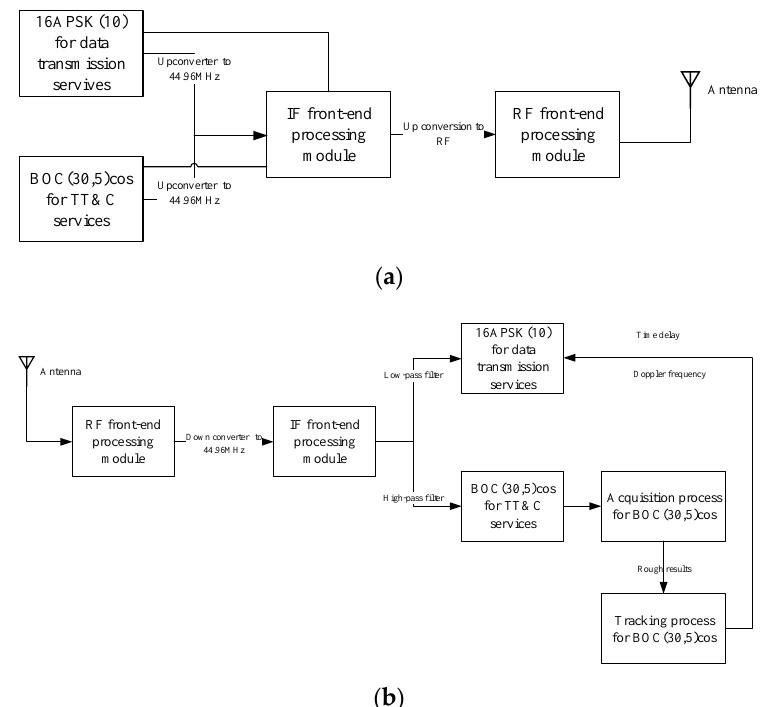
Figure 2. The BOC(30,5)cos and 16APSK integrated signal system. ( a ) Transmission link structure ( b ) Receiving link structure.